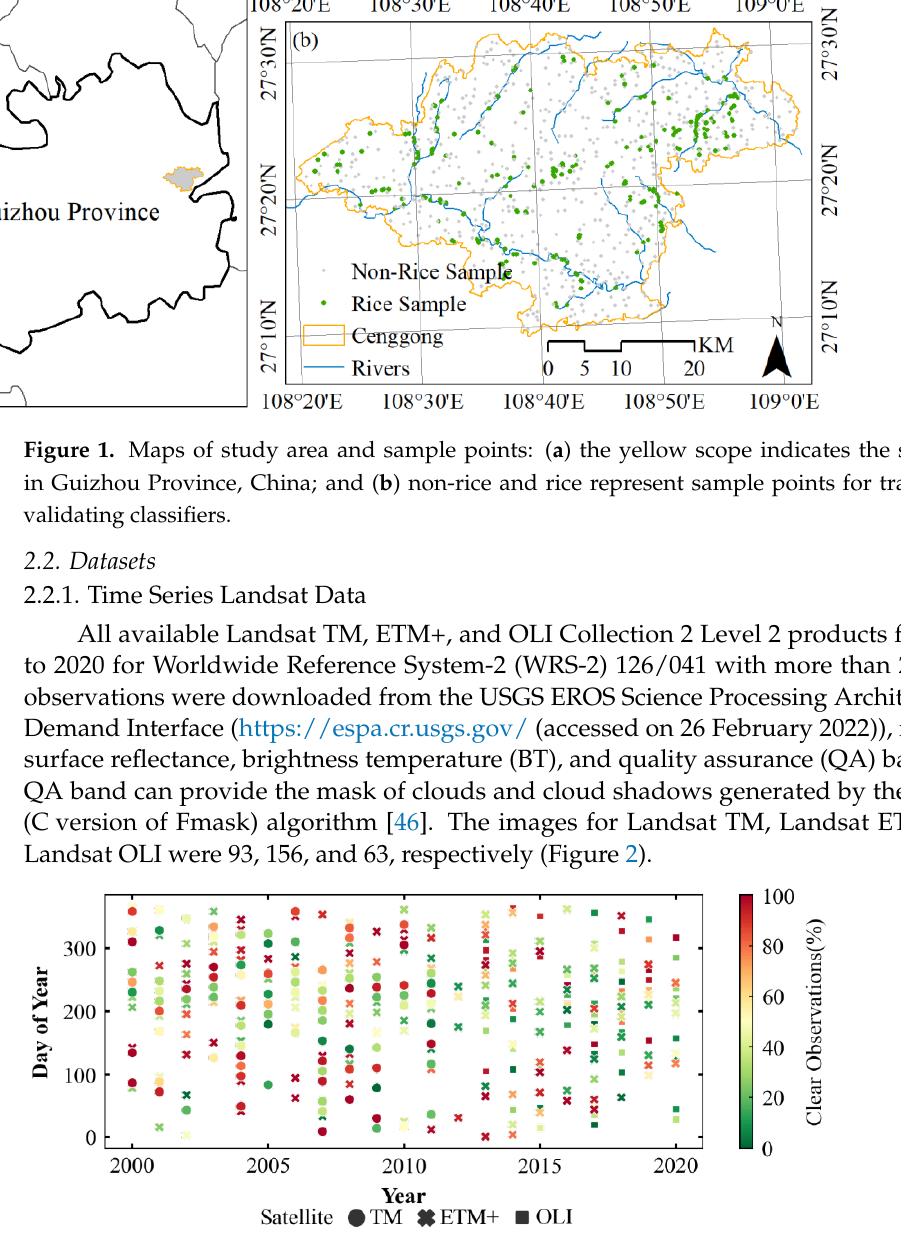
Figure 2. Annual distribution and clear-sky observations of all available Landsat images from 2000 to 2020 in Cengong County (Path/Row: 126/041).